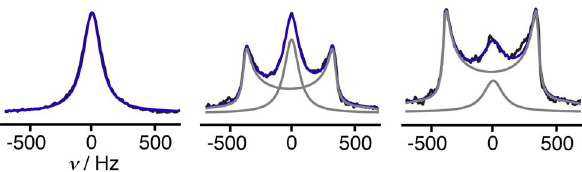
Figure 5. Estimation of the fraction of MLVs ( f MLV ) by spectral deconvolution of 2 H data. The observed spectrum is the sum of contributions from MLVs (singlet) and other lamellar morphologies (doublet). Experimental, fitted, and deconvoluted 2 H spectra are shown with black, blue, and gray lines, respectively. The deconvolution process yields the values f MLV ~ 1 , 0.32, and 0.14 from left to right.